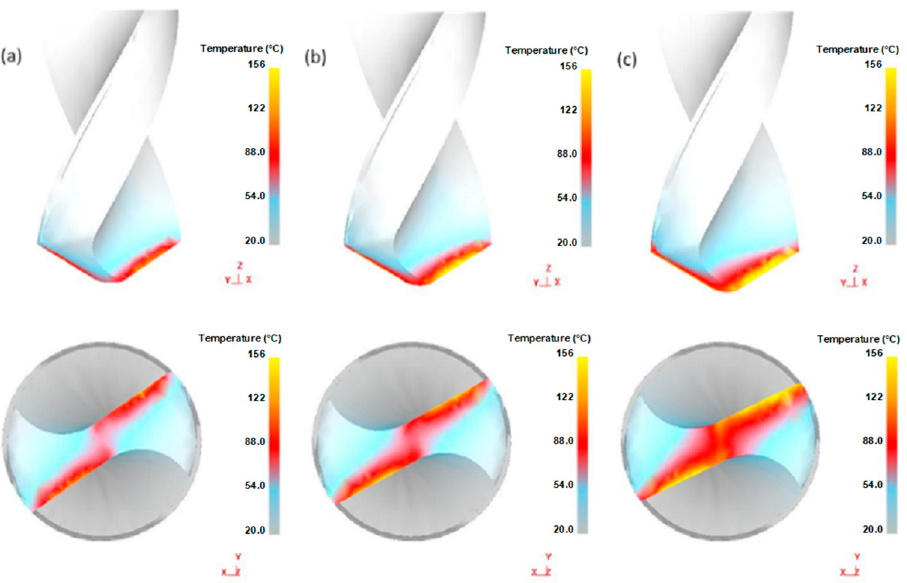
Figure 10. Tool temperature differences at different feed speeds (spindle speed is 1000 rpm): ( a ) the temperature when feeding at 60 mm/min; ( b ) the temperature when feeding at 100 mm/min; and ( c ) the tool temperature when feeding 140 mm/min.